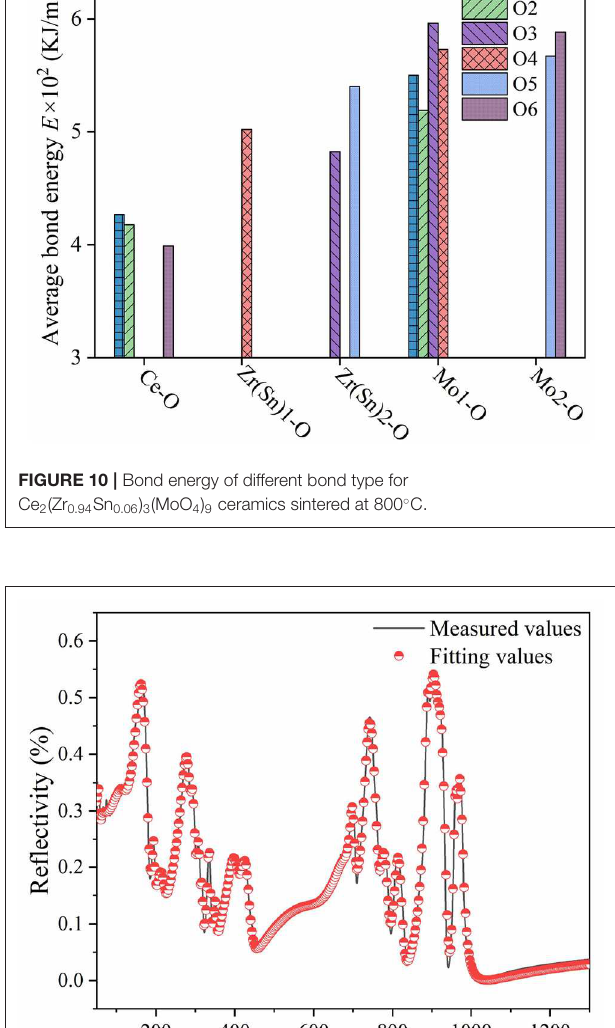
because of the Sn 4 + substitution for Zr 4 + . The higher α Mo value result in large absolute value. Hence, the reduced τ f value was associated with enhanced the thermal expansion coefficient ( α Mo O ). − IR reflectivity spectra of CZSM ceramics was exhibited in Figure 11 . Based on the classical harmonic oscillator model, the infrared spectra were fitted with 24 internal modes, which were listed in Table 3 (Petzelt and Kamba, 2003). ε ∗ ( ω ) (the complex dielectric permittivity) and R ( ω ) (the complex reflectivity) were calculated by Equations (23) and (24) (Wakino et al., 1986; Li et al., 2016; Tang et al., 2019; Guo et al.,